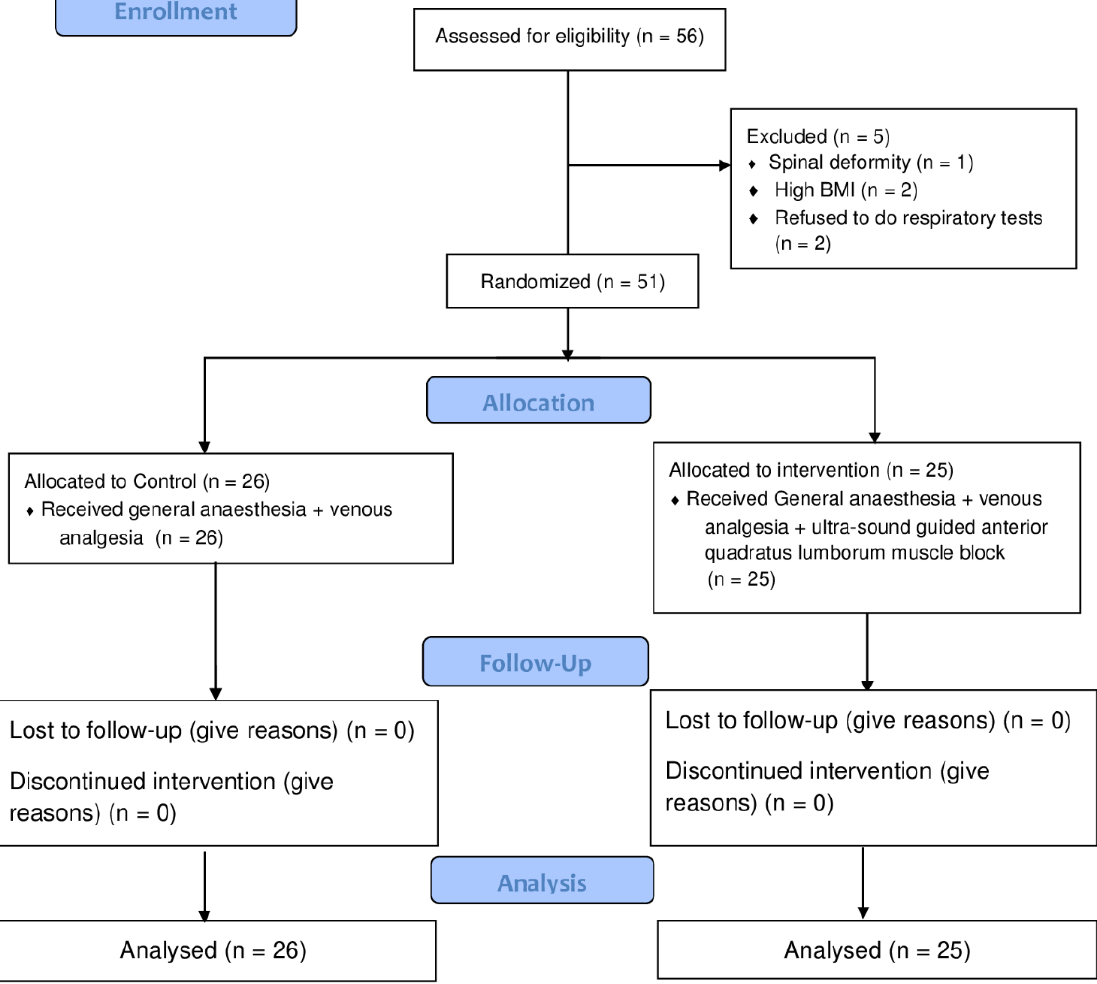
Figure 1. CONSORT study flow diagram.